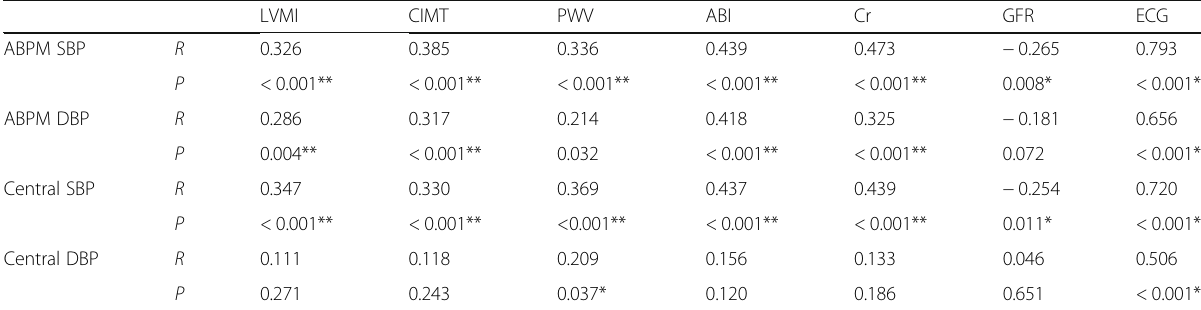
Table 4 The correlation between each blood pressure monitoring and hypertensive end organ damage parameters